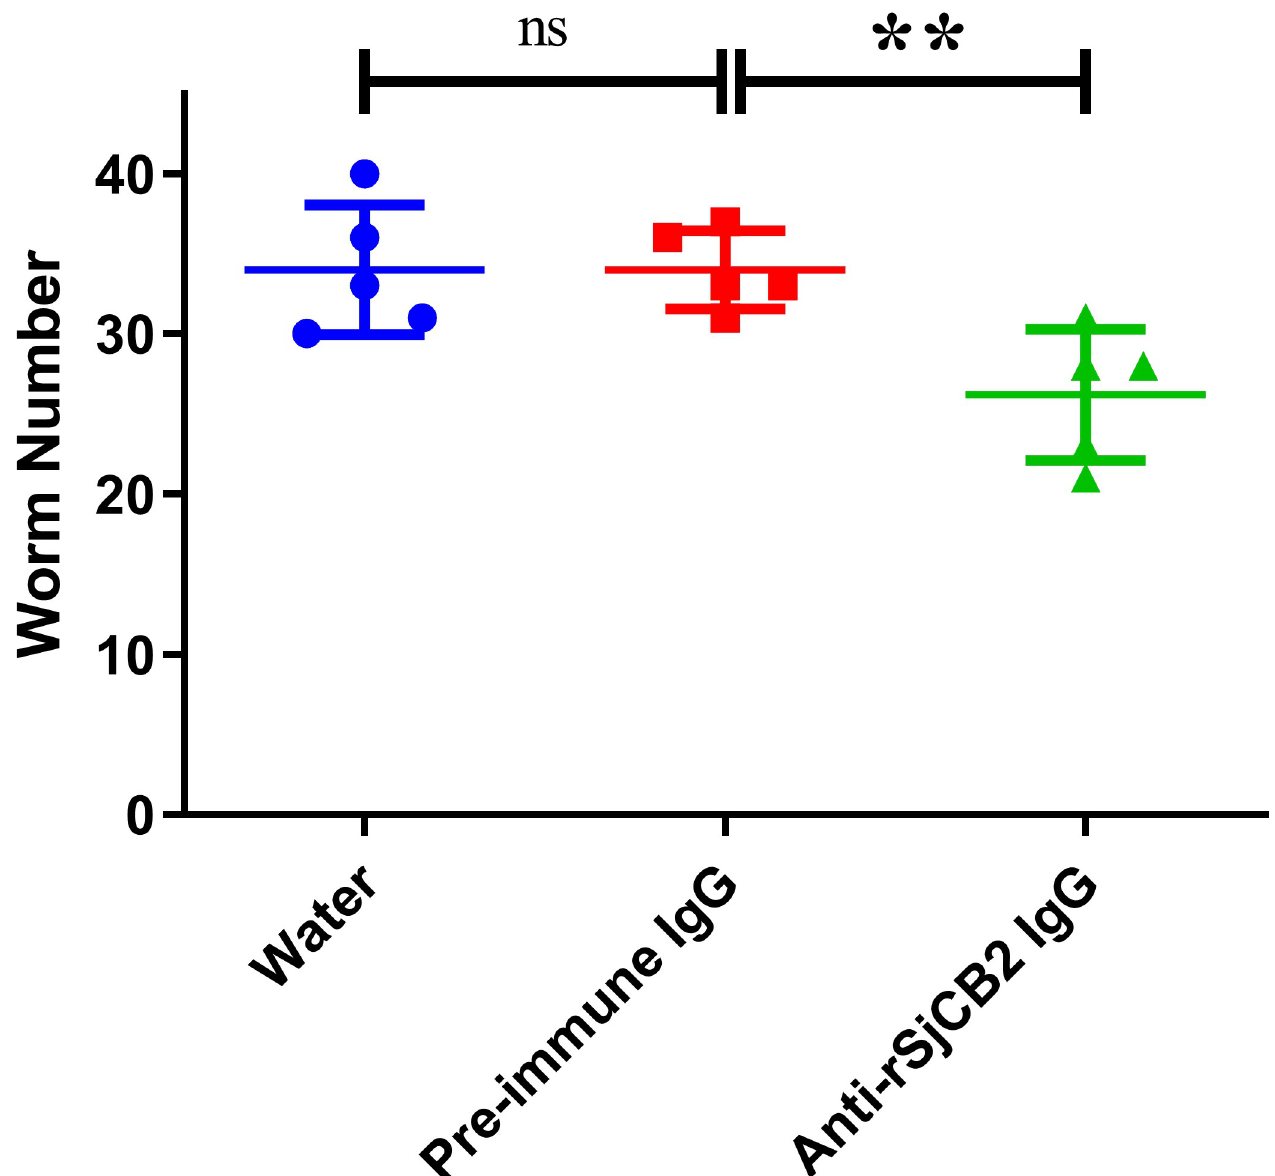
Fig 8. Inhibition of cercariae invasion. Mice were experimentally challenged with 40 S . japonicum cercariae and adult worms were collected 28 days post infection. Statistically significant difference ( �� = p-value < 0.01, � = p-value <